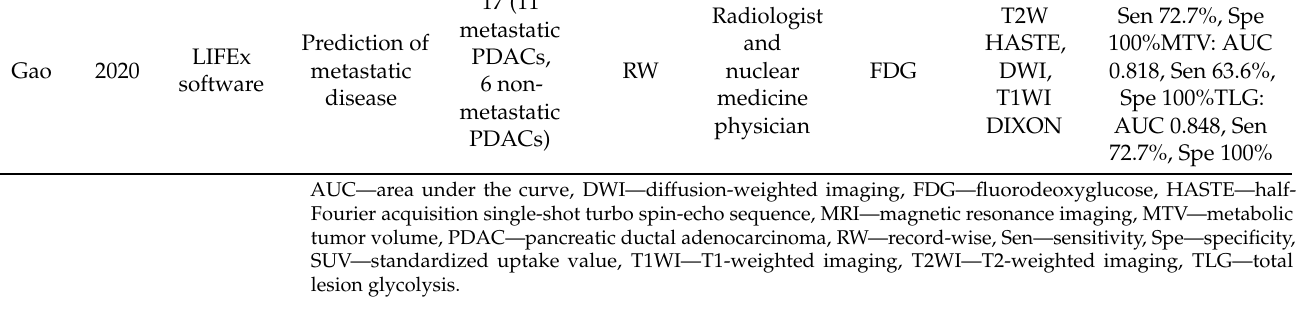
Table 5. Applications of radiomics in pancreatic CT and MRI